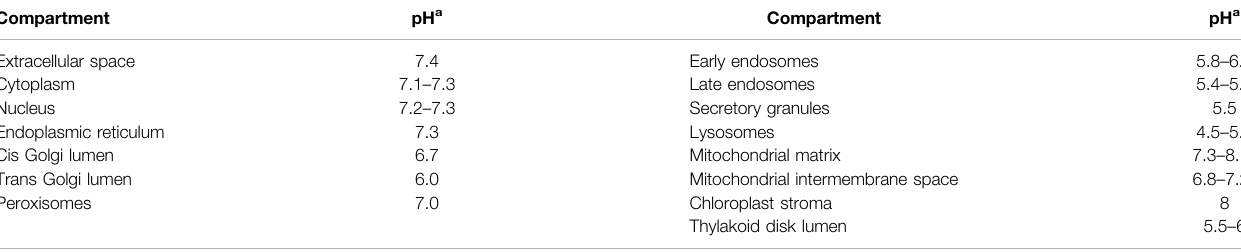
TABLE 1 | pH of cellular compartments under normal (non-disease state) conditions.